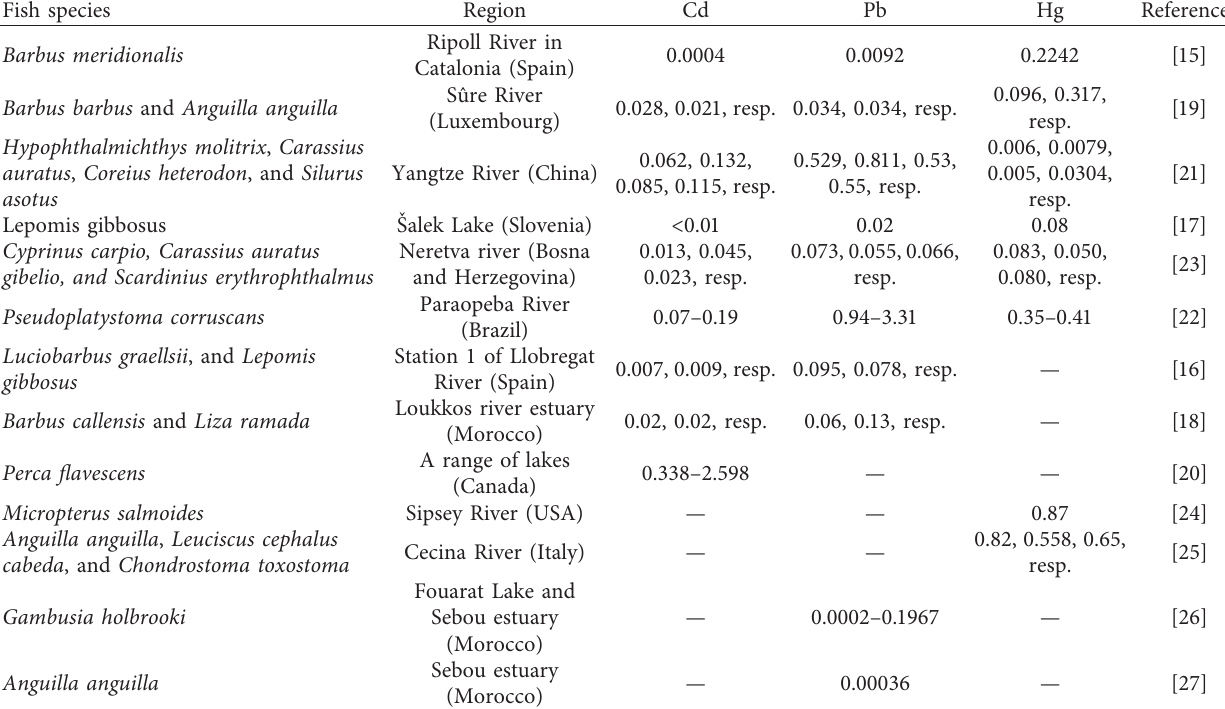
Table 5: Comparisons of recorded trace metal levels in the muscles of the fish species during the present study with literature reported from different areas (mg/kg of wet weight).